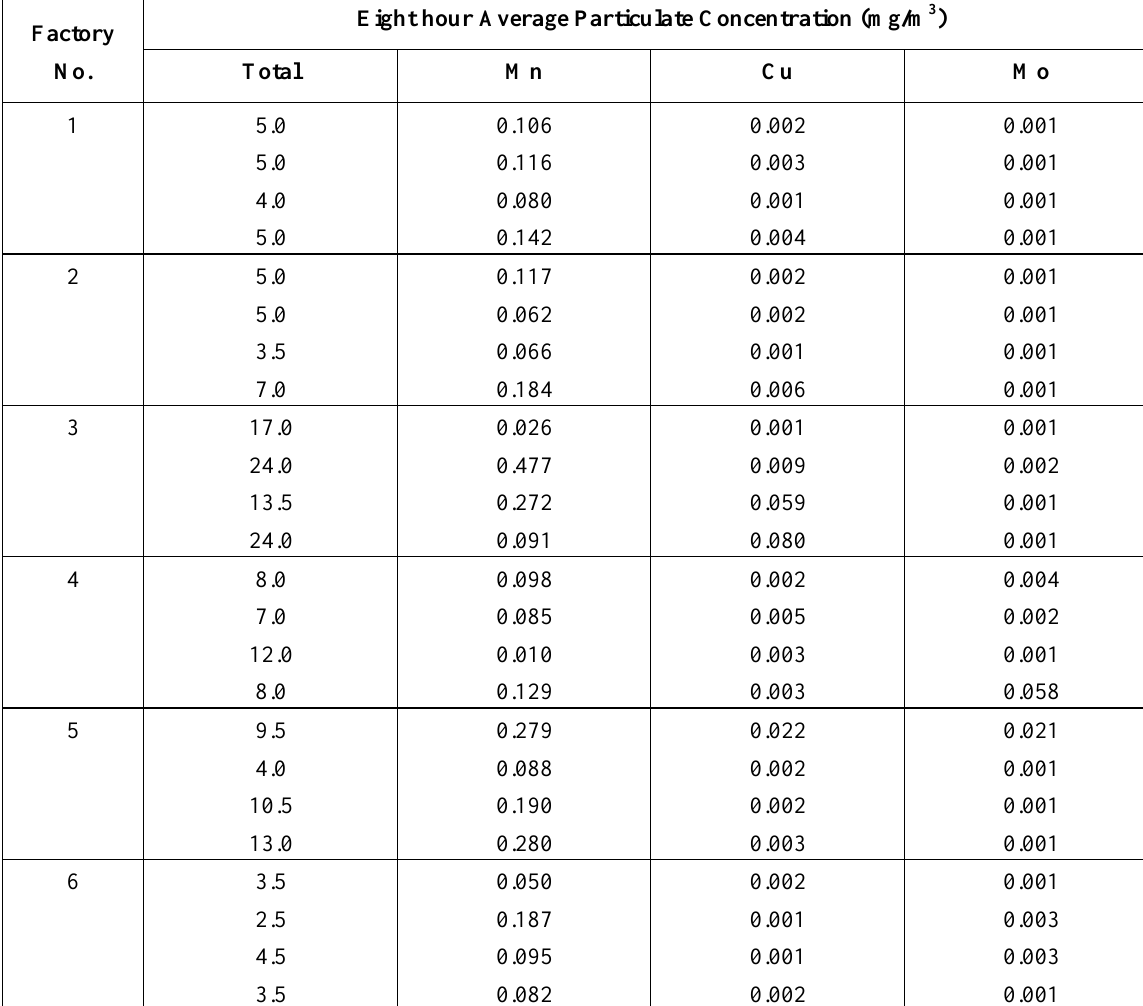
Table 3. Eight Hour Average Metal Concentrations of Welding Fume In Each Factory.